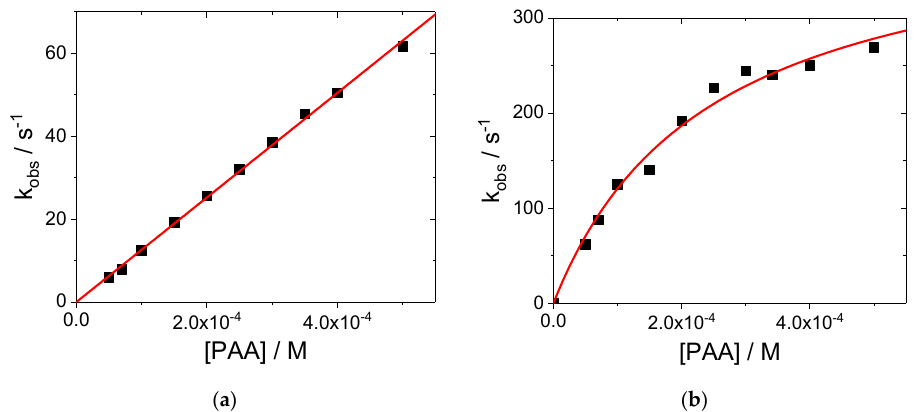
Figure 3. Plot of k obs versus PAA concentration for the reaction of Mn III (TPPS) with PAA: ( a ) at pH = 9.3 in carbonate buffer; ( b ) at pH = 11 in 0.5 M Na 2 CO 3 + NaHCO 3 solution. Experimental conditions: [Mn III (TPPS)] = 6 μ M, [PAA] = 50–500 μ M, T = 25 °C.